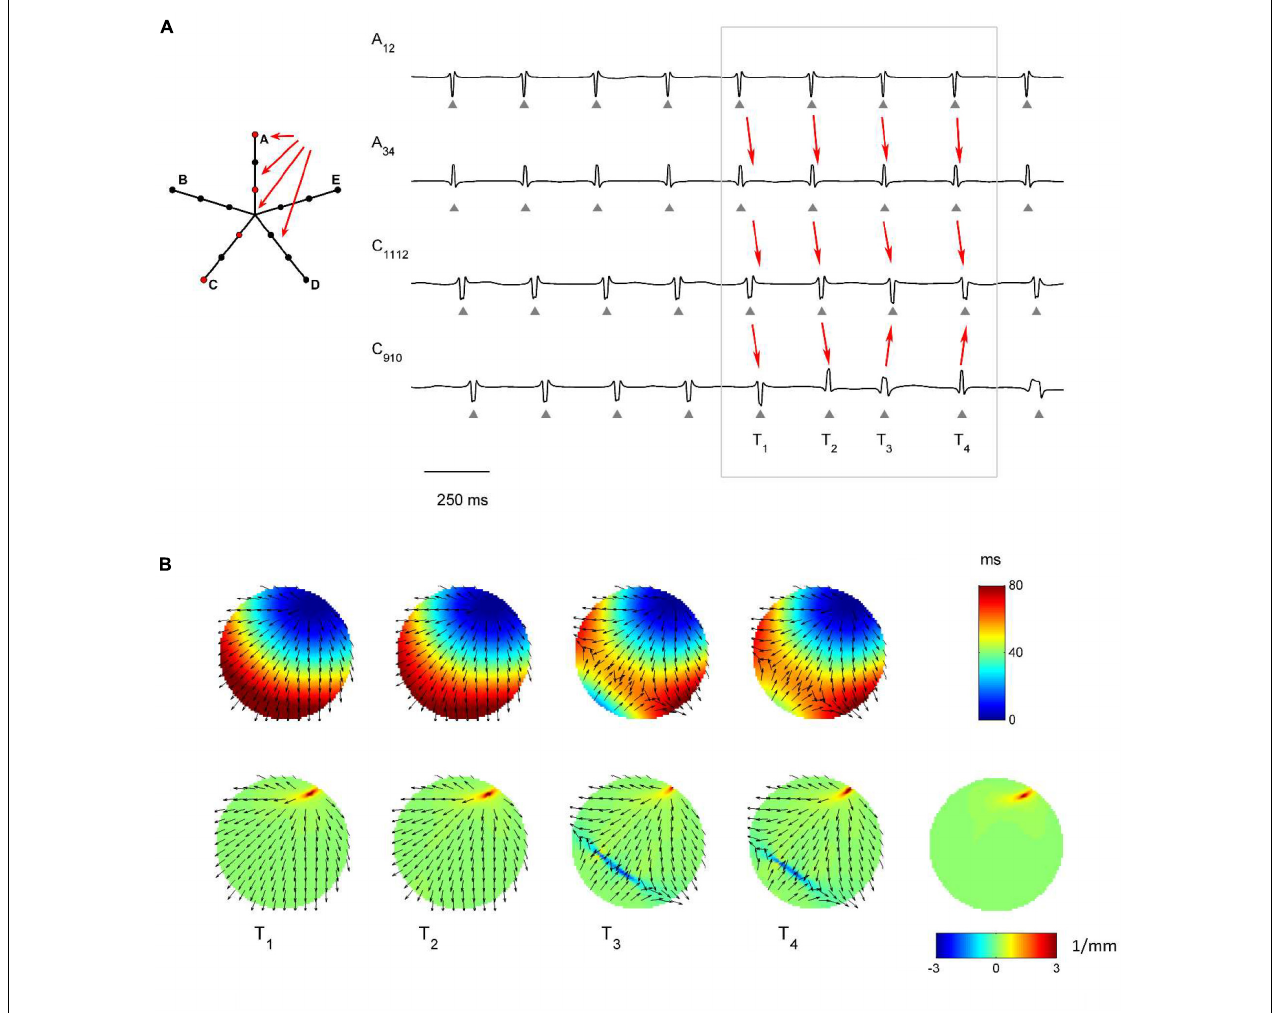
FIGURE 6 | Application of divergence analysis to simulated atrial fibrillation at the boundary between the focal driver and multiple wavelets region. (A) Schematic representation of the multipolar mapping system, indicating the central position of the bipoles, and representative synthetic electrograms corresponding to the red bipoles of the catheter. Arrows indicate the prevalent activation sequence. (B) Beat-to-beat reconstructed activation (top) and divergence maps (bottom) corresponding to the evidenced beats. The average divergence map over the analyzed epoch is displayed in the bottom right panel. The presence of the focal driver is evidenced by positive divergence values (red), while collision lines are indicated by negative values